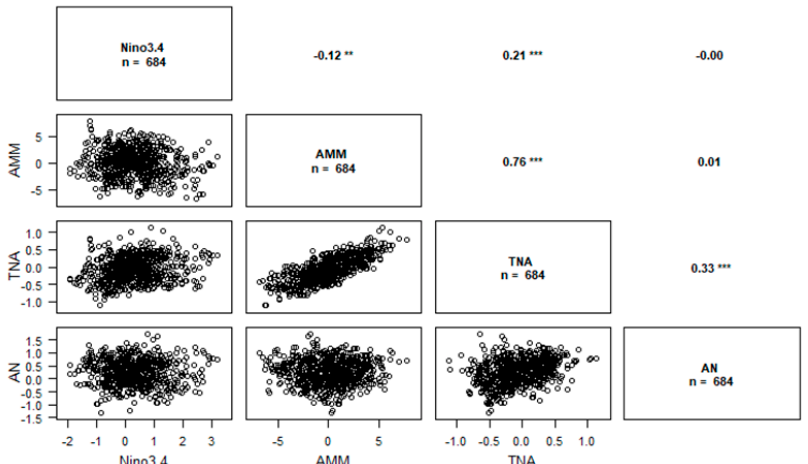
Figure 8. Correlation between the standardized monthly Niño3.4, AMM, TNA and AN time series for the period from 1960 to 2016, “n” is data number. The values are the correlation coefficient between the 4 parameters and we found that TNA and AMM are significantly correlated. The “***”; “**”; “*“; show that the correlation is significant to the 0.001; 0.01; 0.1 level and ” “ mean that there is no correlation.